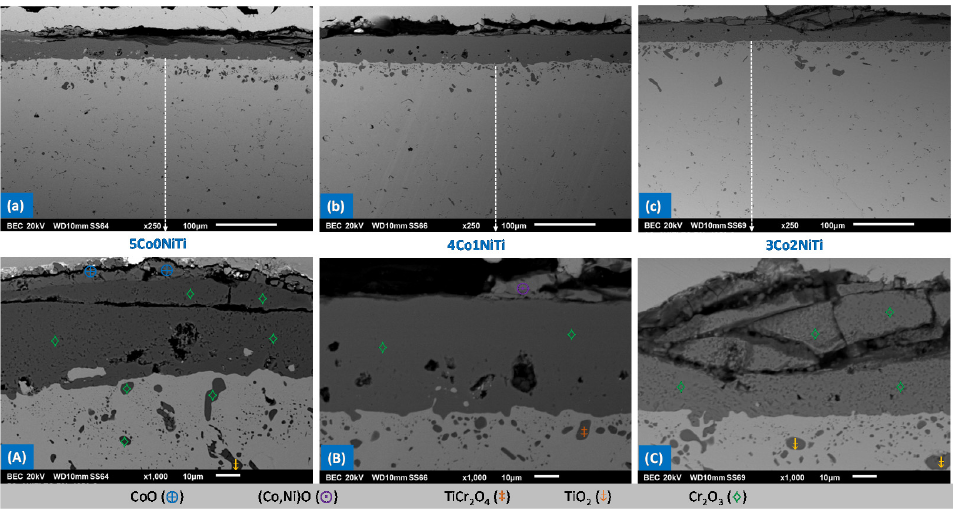
Figure 9. Cross-sectional observation of the external oxides and of the subsurfaces affected by oxidation (Co-richest alloys); white dotted arrows: line scans corresponding to the concentration profiles presented in Figure 11; ( a ) and ( A ): 5Co0NiTi, ( b ) and ( B ): 4Co1NiTi, ( c ) and ( C ): 3Co2NiTi.